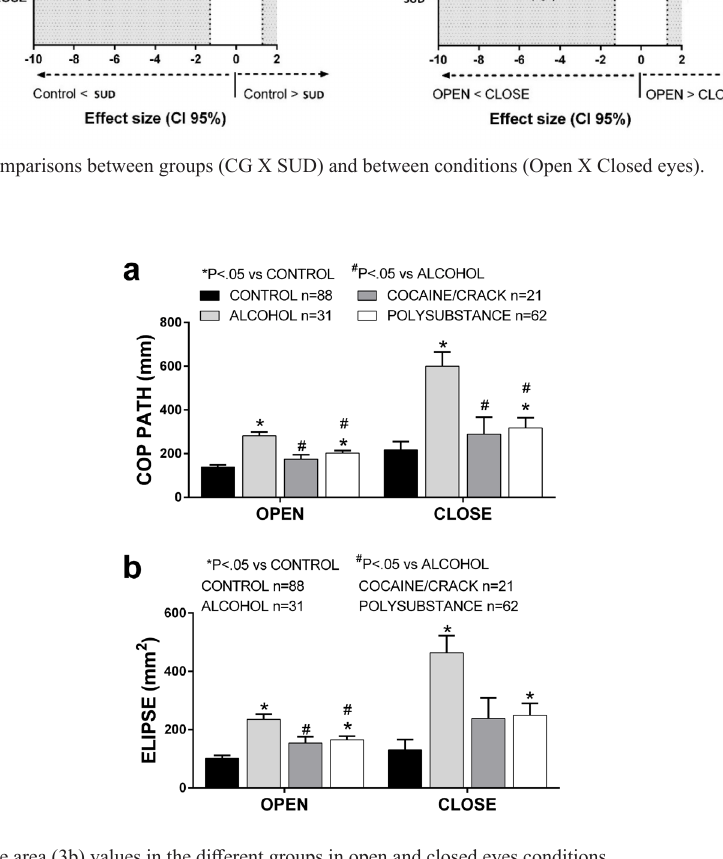
Figure 3. COP Path (3a) and Ellipse area (3b) values in the different groups in open and closed eyes conditions